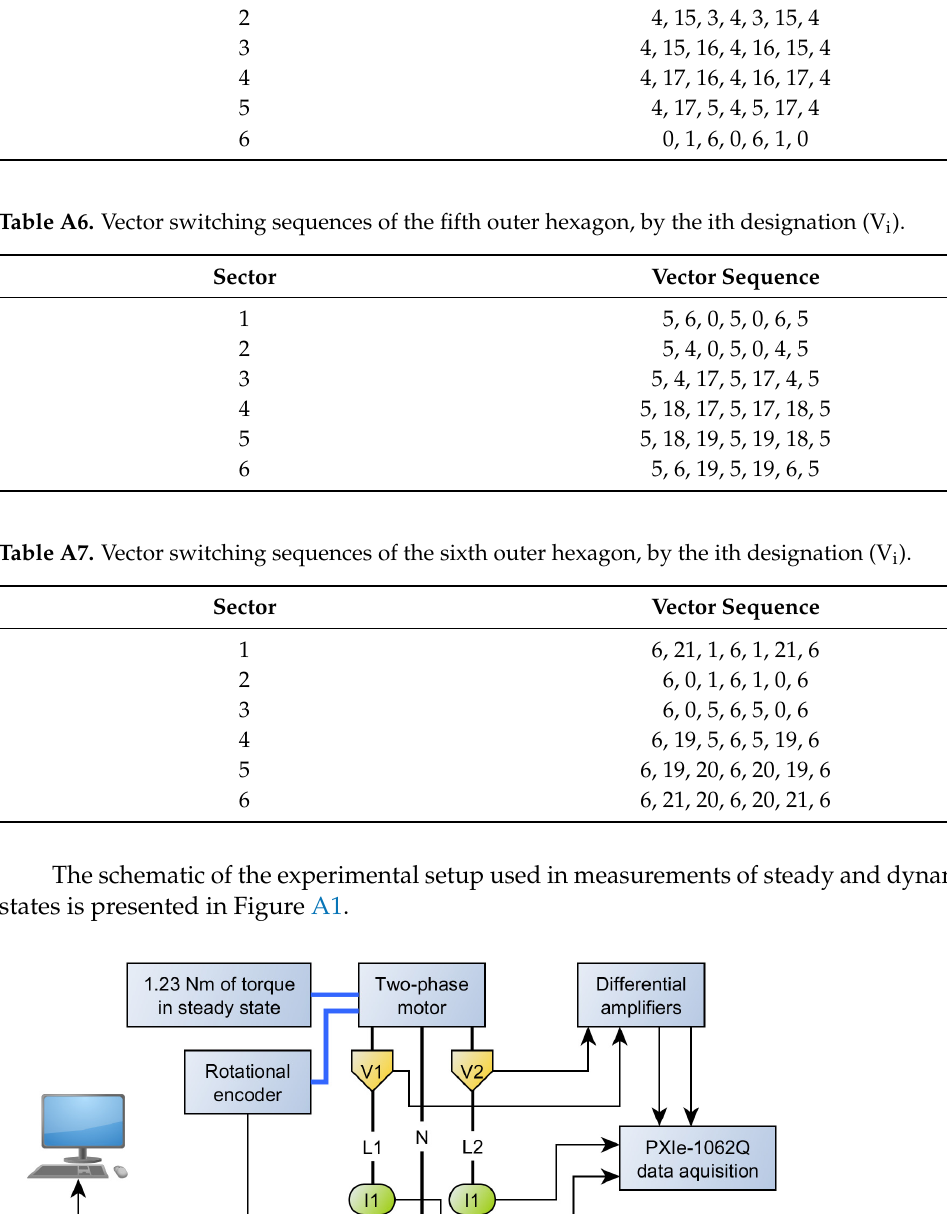
Table A5. Vector switching sequences of the fourth outer hexagon, by the ith designation (V i ).